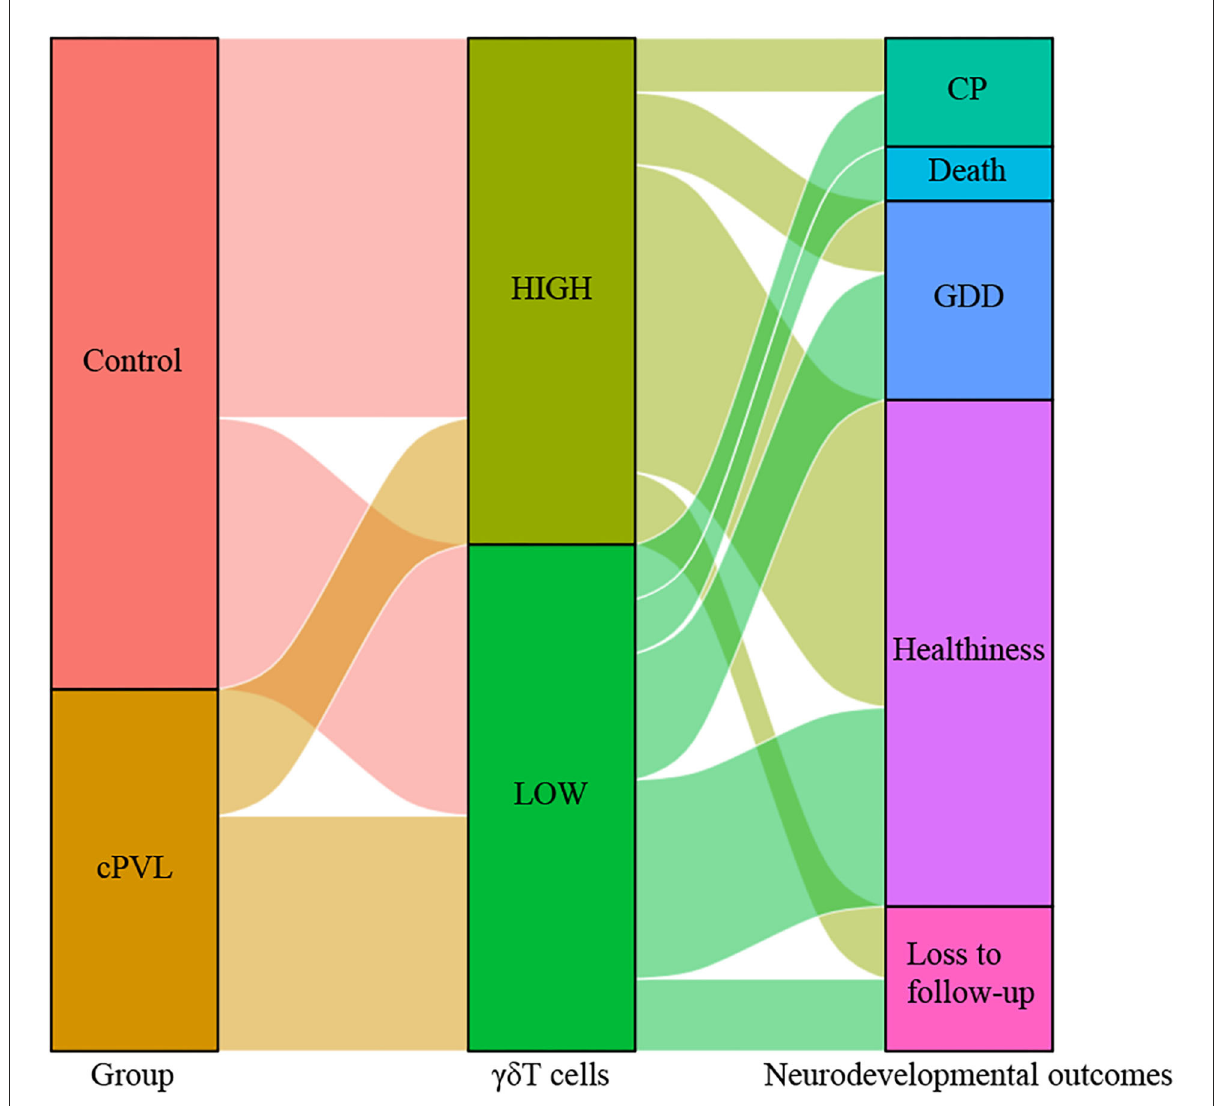
FIGURE6 Sankey diagram representing the relationship between γδ T cell levels and neurodevelopmental outcomes between the cPVL group and control group. Using the median of γδ T cells as a criterion to divide into high and low values to connect two groups of preterm infants and neurodevelopmental outcomes, γδ T cell levels can be seen in the Sankey diagram to represent a worse neurodevelopmental outcome. CP, cerebral palsy; GDD, global developmental delay.